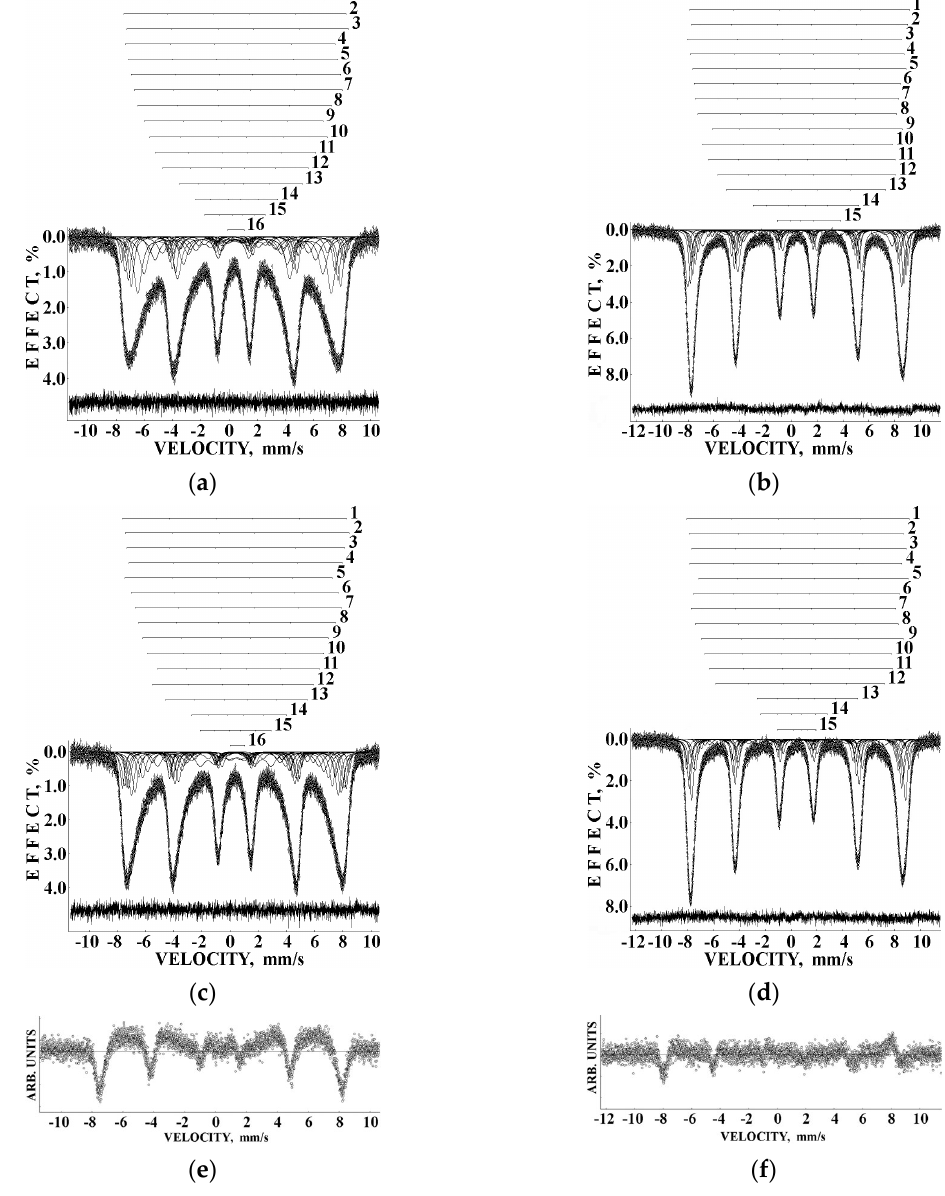
Figure 31. Mössbauer spectra of the as ‐ prepared Fe 3 O 4 nanoparticles ( a , b ) and those dispersed in Copaiba oil Fe 3 O 4 ‐ CO ( c , d ) measured in 4096 channels at 295 K ( a , c ) and 90 K ( b , d ), and normalized differences between the Mössbauer spectra of the as ‐ prepared Fe 3 O 4 and dispersed in Copaiba oil Fe 3 O 4 –CO measured at 295 K ( e ) and 90 K ( f ). Indicated components 1–16 ( a , c ) and 1–15 ( b , d ) are the results of the best fits. The differential spectra are shown on the bottom ( a – d ). Adapted from Ref. [72] with permission from Elsevier: Spectrochimica Acta, Part A: Molecular and Biomolecular